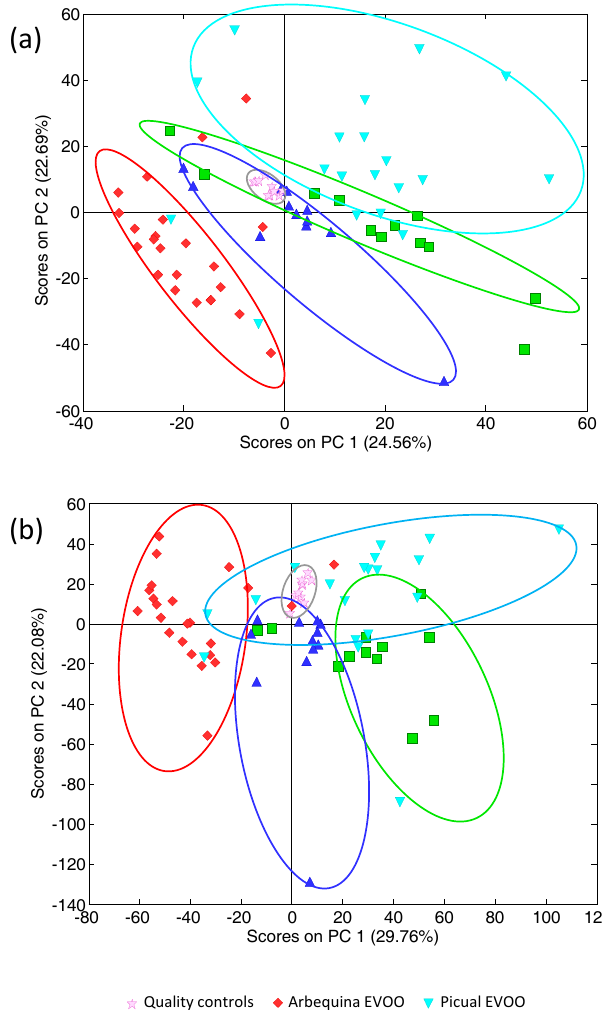
Figure 3. Principal component analysis (PCA) results (scatter score plot of PC1 vs. PC2) in the analysis of 66 EVOOs obtained from monovarietal olive cultivars by employing as data: ( a ) HPLC-UV chromatographic profile segments of 5–8 min, 13–21 min, and 23–26 min simultaneously (registered at 280 nm); and ( b ) a combination of the HPLC-UV chromatographic profile segments from 13 to 32 min obtained at 257, 280, and 316 nm, simultaneously.